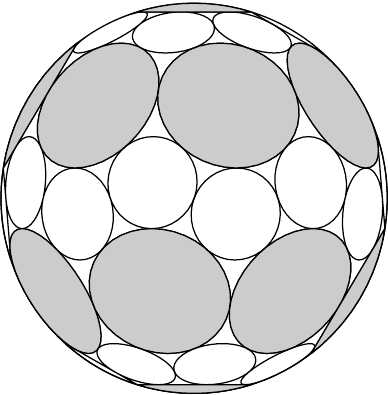
Figure 5.1. The layered circle packing with defining sequence { 7,5,7,5,7 } . The circles of degree 7 are shaded. Notice that the combinatorics forces the packing to cover a sphere.